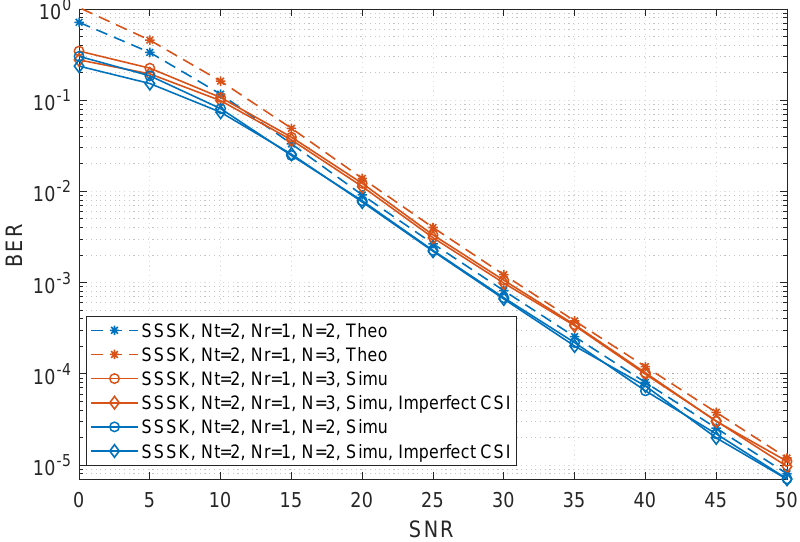
Figure 1. Performance comparisons between the sparse SSK for different values of N and the conventional SSK having N t = 2, N r = 1, where the spectral efficiency is equal to 1.5 bits/s/Hz for N = 2 and 1.333 bits/s/Hz for N = 3.